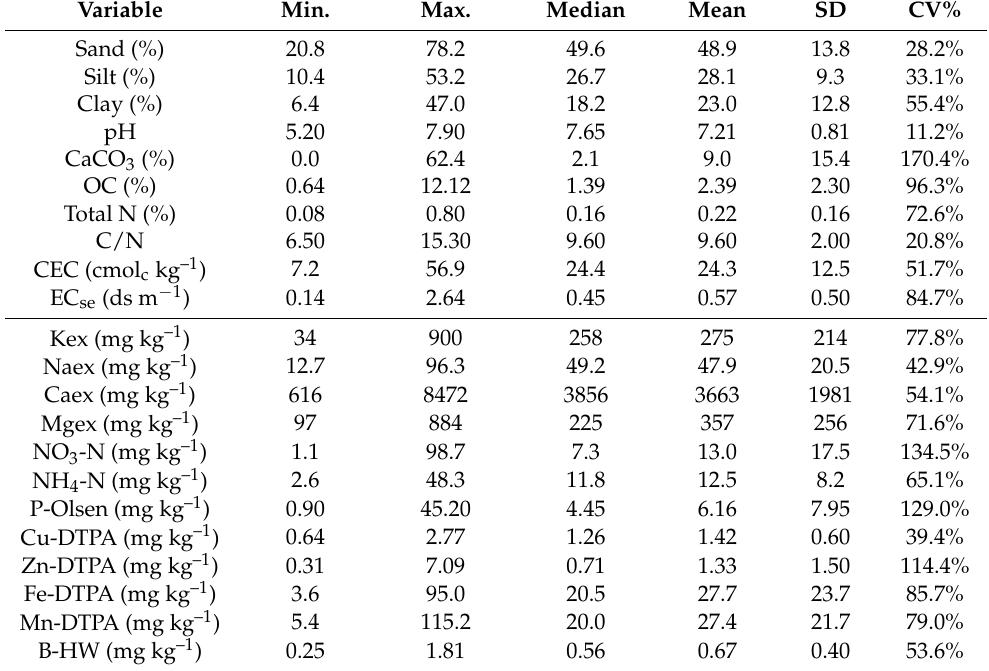
Table 3. Descriptive statistics of the studied physicochemical soil properties and the respective soil available concentrations of macro- and micro-nutrients. SD: standard deviation; CV: coefficient of variation; OC: organic carbon; CEC: cation exchange capacity; EC se : electrical conductivity of the saturation extract; Kex, Naex, Caex, Mgex: exchangeable amounts of K, Na, Ca, Mg, extracted with the ammonium acetate method; and B-HW: Boron extracted with the hot water method. Variable Min.